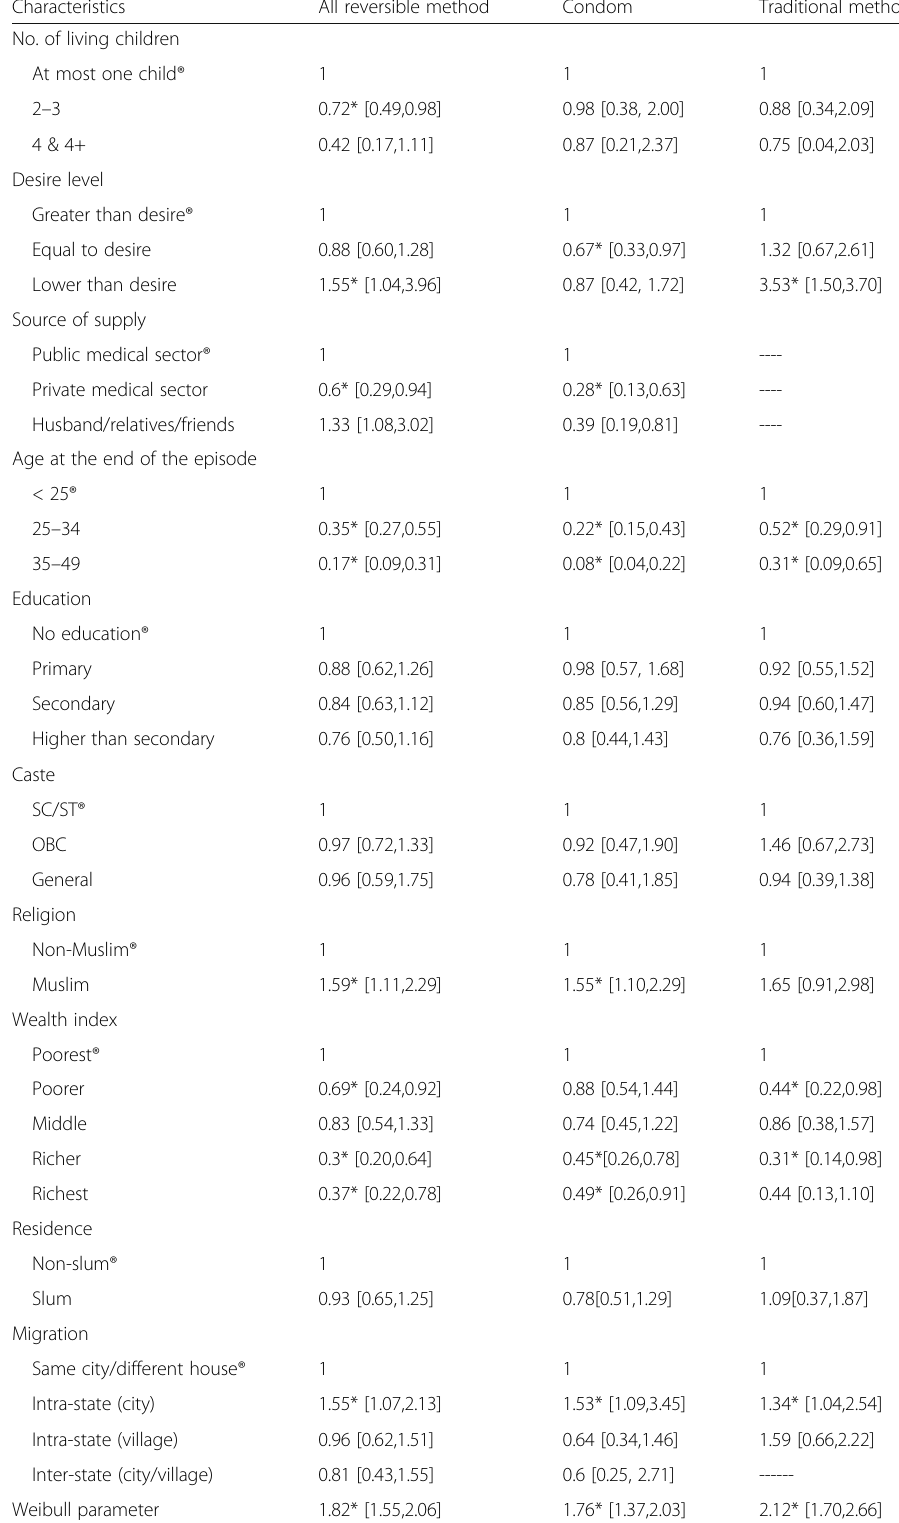
Table 4 Results from Weibull hazard regression of contraceptive failure rates within 1 year of method adoption for all methods combined traditional method and for condom, by selected characteristics of female users, Uttar Pradesh, 2009 –